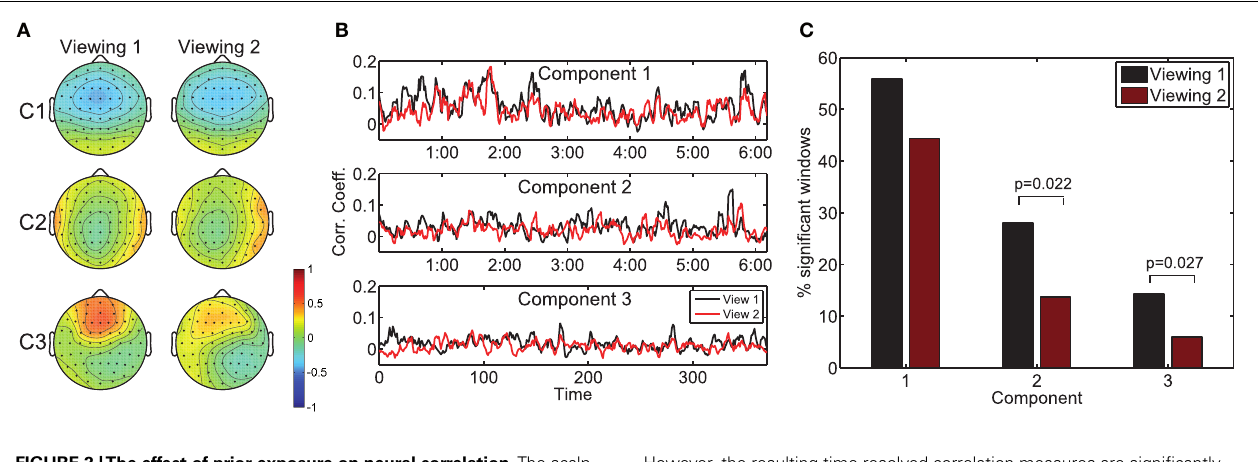
FIGURE 2 |The effect of prior exposure on neural correlation. The scalp projections of the components maximizing population ISC during the first viewing are largely congruent to those stemming from viewing 2 (A) .